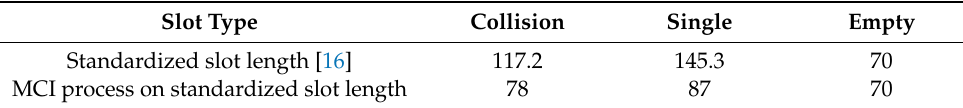
Table 1. Slot length in µ s with and without MCI process.